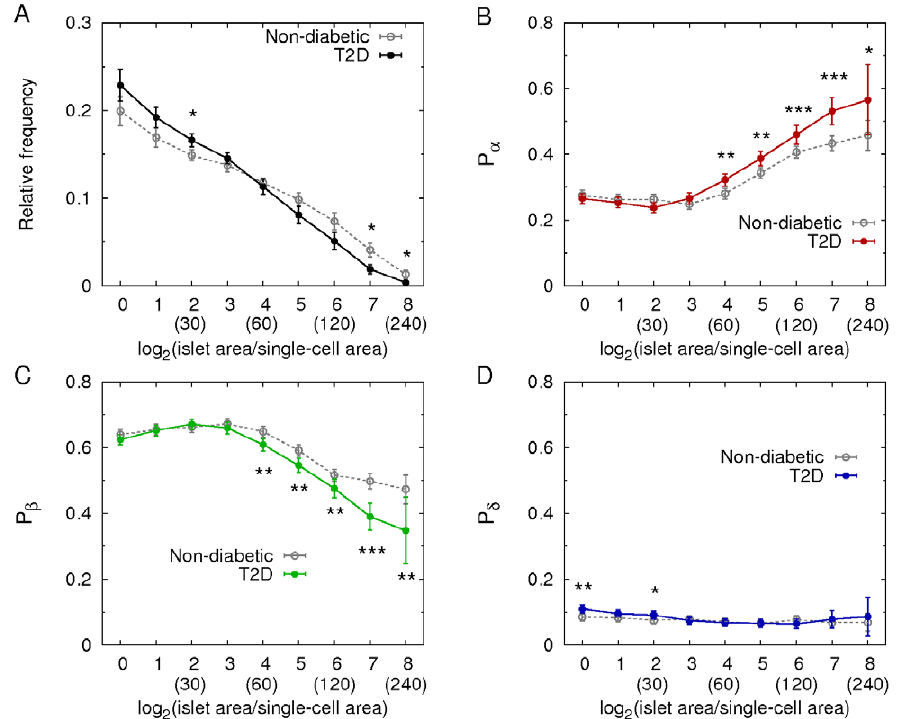
Figure 6. Changes of islet size and cellular compositions in T2D. A: Mean relative frequencies of islet sizes and cellular compositions ( B: alpha-cell fraction, C: beta-cell fraction, and D: delta-cell fraction) depending on islet size in non-diabetic (gray; 8903 islets with n=14) and T2D (color; 7929 islets with n=12) subjects (mean 6 SEM). The numbers in parentheses represent effective islet diameters ( m m) corresponding to the given logarithmic dimensionless islet areas. Student’s t -test compared the results between non-diabetic and T2D subjects at each size bin with *P , 0.05, **P , 0.001, and ***P , 0.0001.